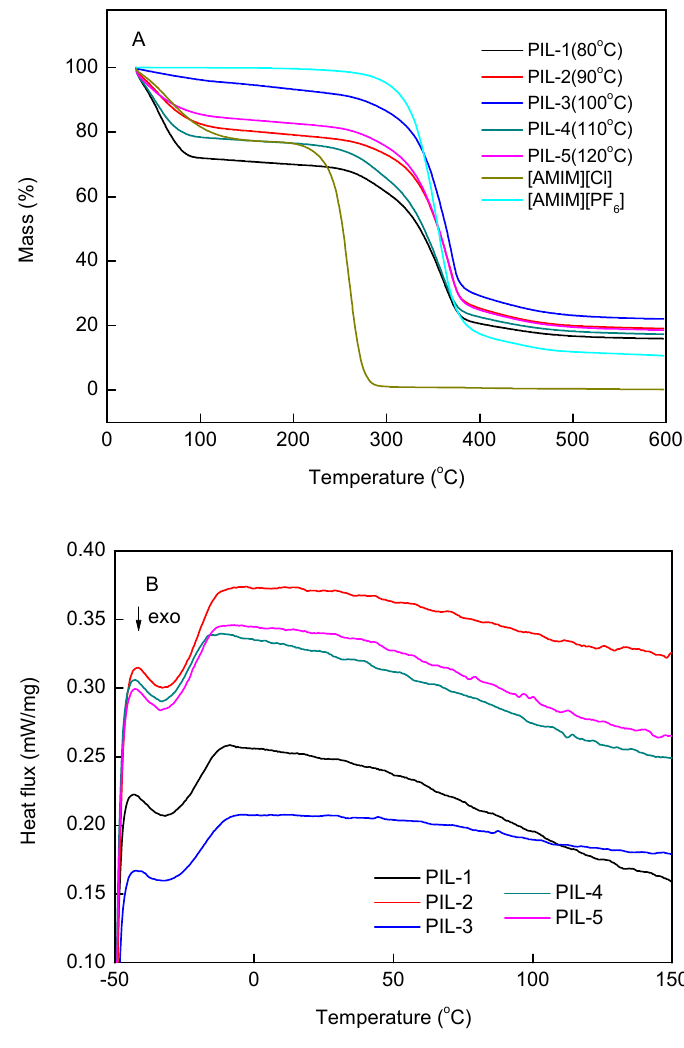
Figure 3. Thermogravimetric curves of [AMIM][Cl], [AMIM][PF 6 ] and PILs. ( A ) DSC curves of PILs ( B